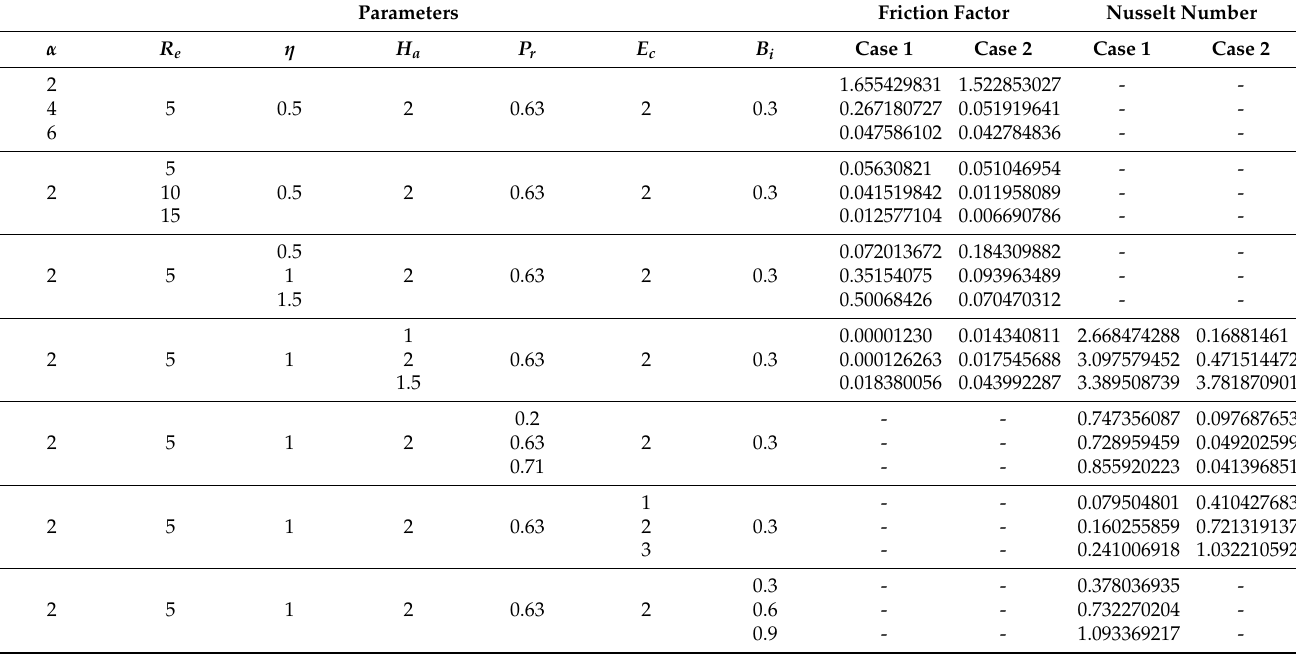
Table 1. The numerical value of skin-friction and Nusselt number for distinct physical parameters.